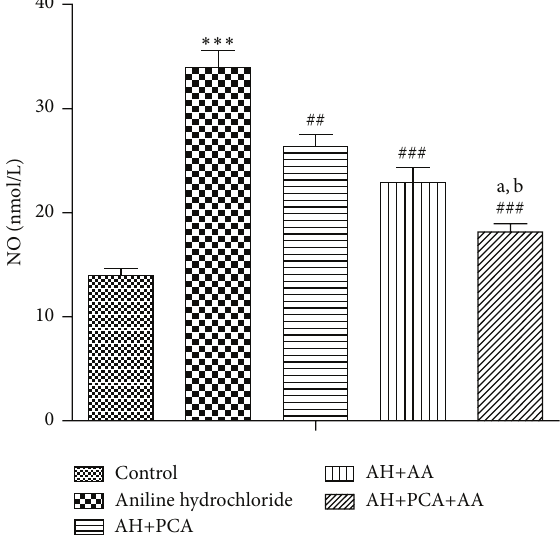
Figure 7: Effect of PCA alone and in combination with AA on nitricoxidein AH-treated rats.Values areexpressed asmean ± SEM. Level of significance is considered as ∗ 𝑝 < 0.05 , ∗∗ 𝑝 < 0.01 , and ∗∗∗ 𝑝 < 0.001 compared to control group. # 𝑝 < 0.05 , ## 𝑝 < 0.01 , and ### 𝑝 < 0.001 compared to AH-treated group. a 𝑝 < 0.05 compared to AH+PCA and b 𝑝 < 0.05 compared to AH+AA